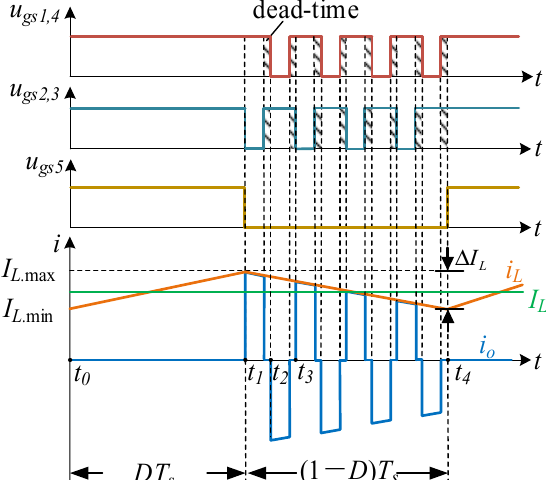
Figure 7. Sequence diagram of the proposed inverter. Figure 6. Sequence diagram of the proposed inverter.